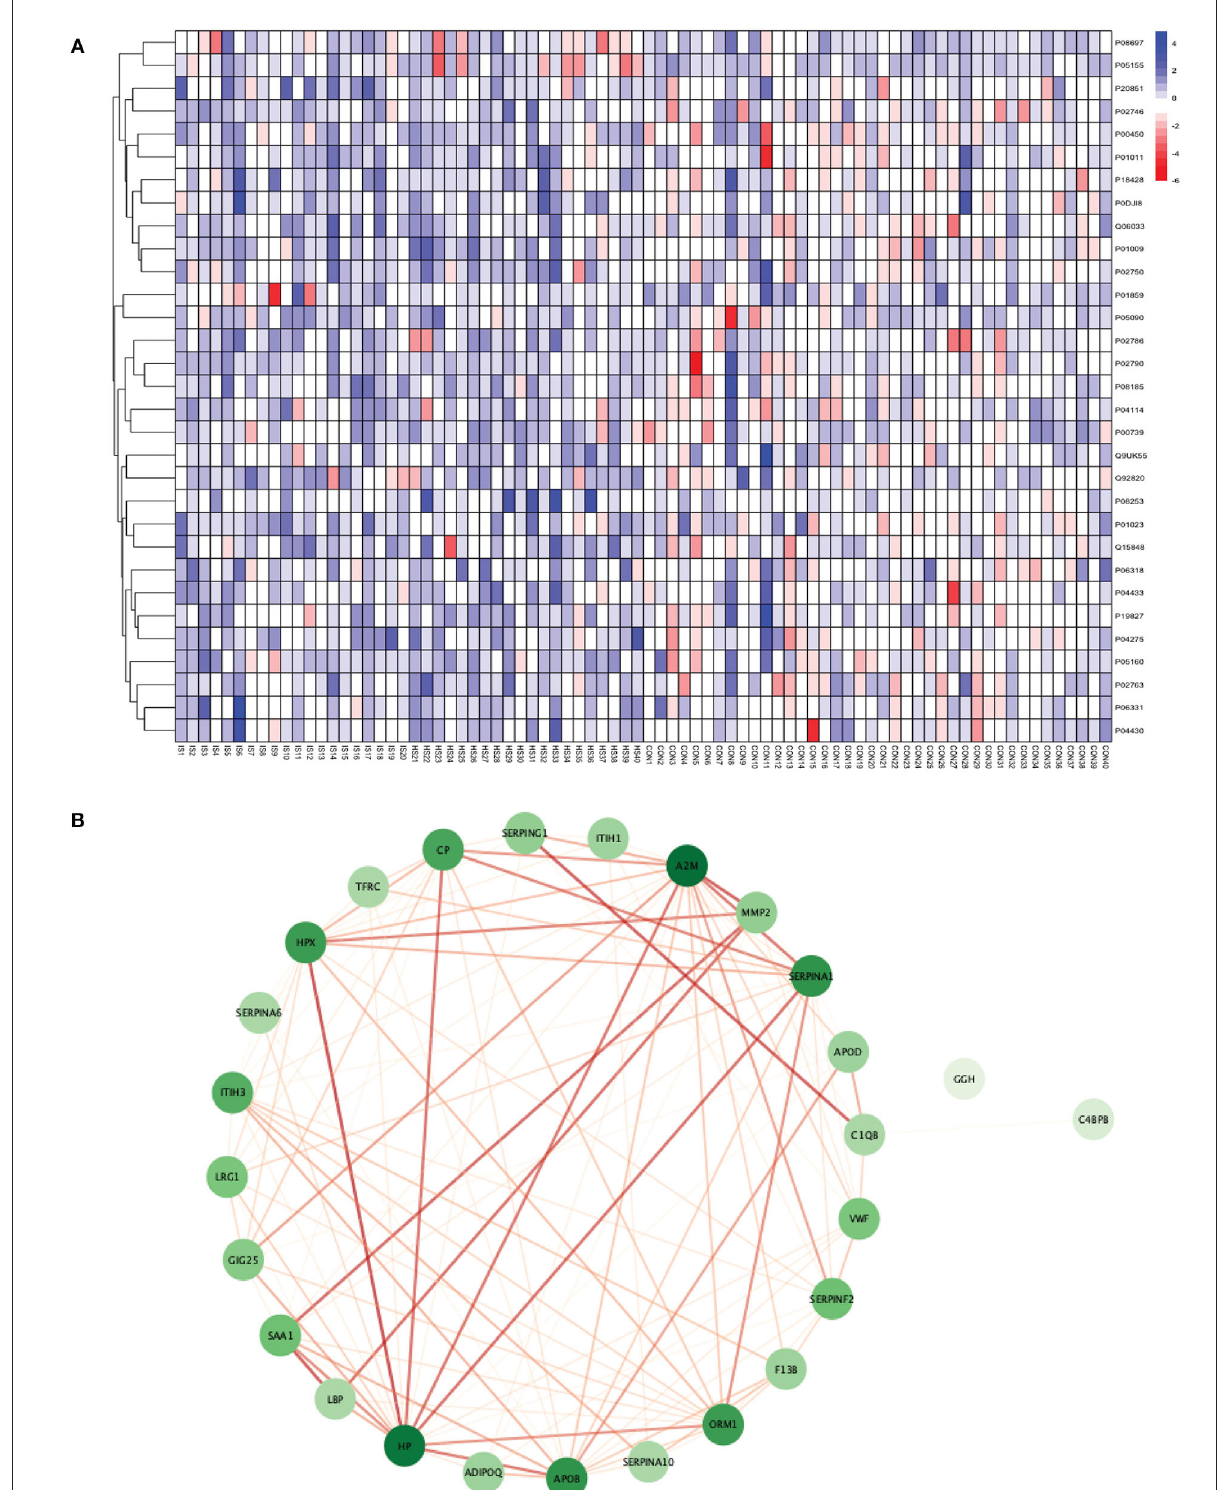
FIGURE3 (A) Heatmap showing the distribution and expression pattern of 31 significantly differentially expressed proteins between total stroke and healthy controls. Each column represents a different subject, while each row represents the UniProt ID of different proteins. The blue squares represent upregulated, and the red squares represent downregulated proteins in total stroke compared to healthy controls. White squares represent no change in protein expression. (B) Protein–protein interaction network analysis of differentially expressed proteins between